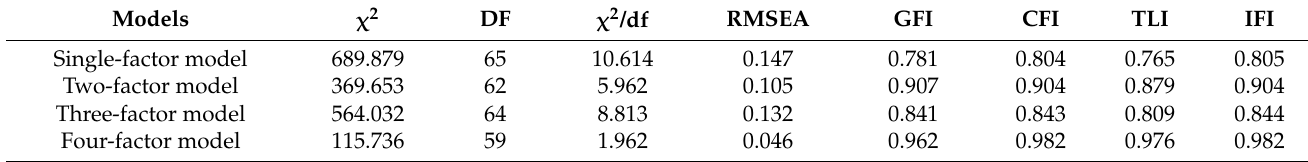
Table 2. Confirmatory factor analysis results of the four-dimensional model for employee green behavior.